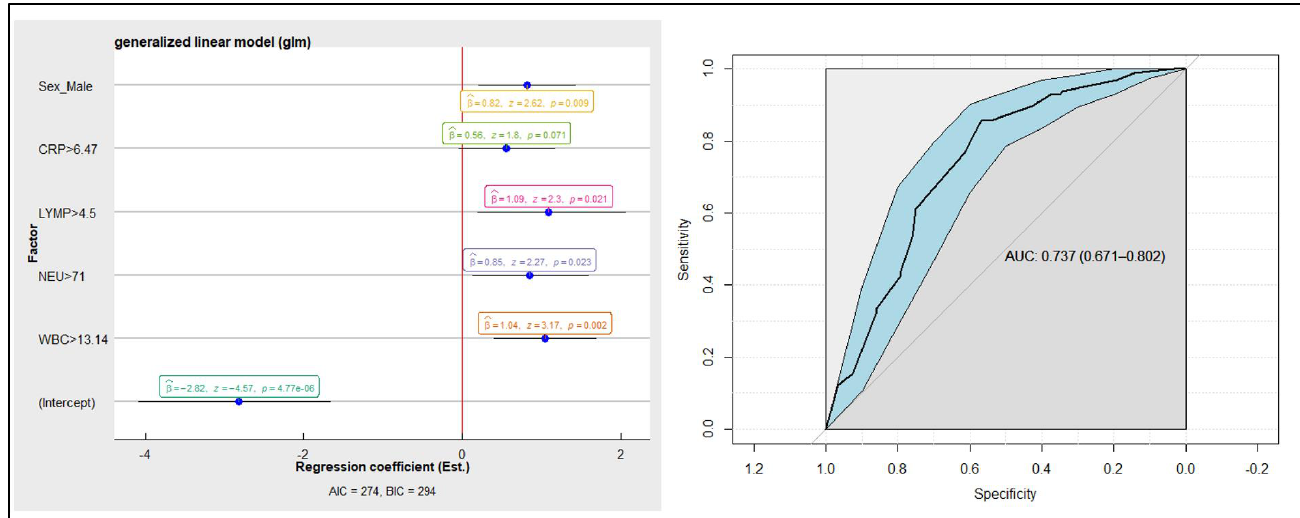
Figure 3. Linear logistic regression model with area under the curve (AUC) presented graphically.